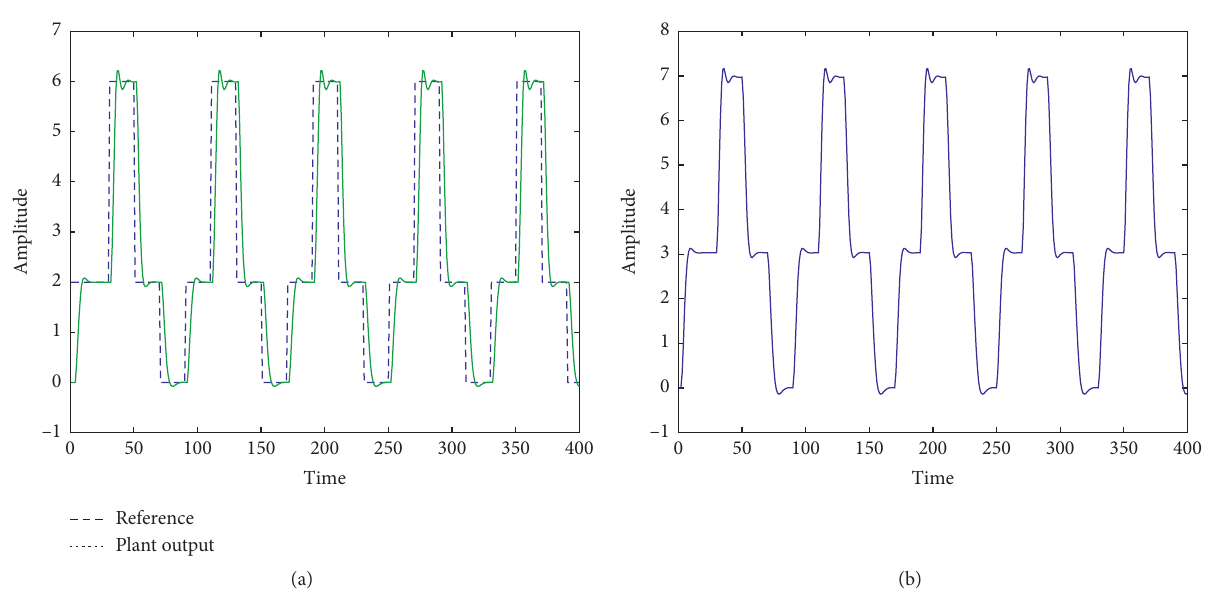
Figure 8: (a) Plant output. (b) Control